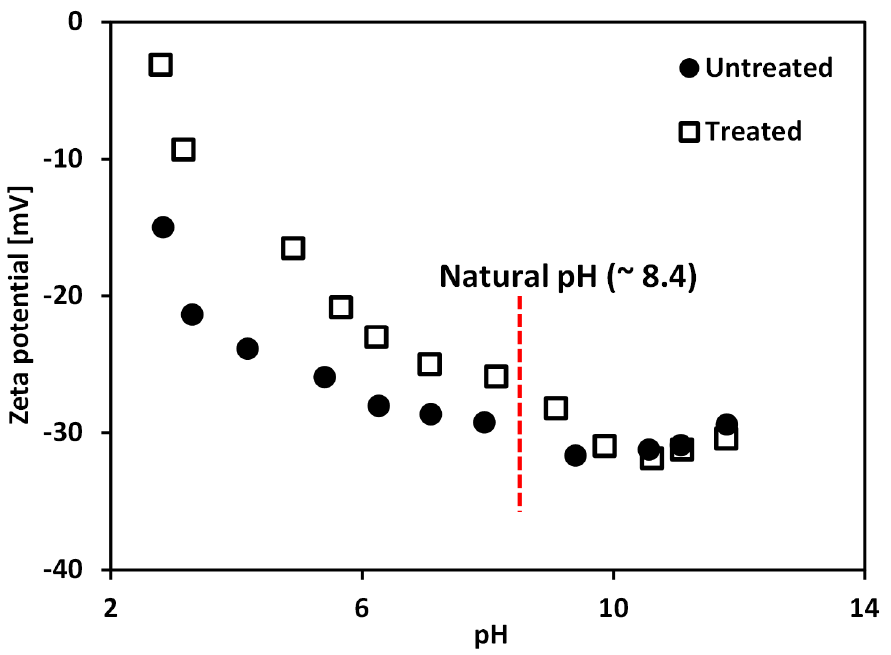
Figure 5. Variations of zeta potential of treated and untreated clays as a function of pH. Note zeta potential was measured using zeta potential analyzer (Otsuka Electronics, ELSZ-1000, Osaka, Japan) with the sample of 0.6 g of dry soil dispersed in 1 L of 0.01 M NaCl solution.